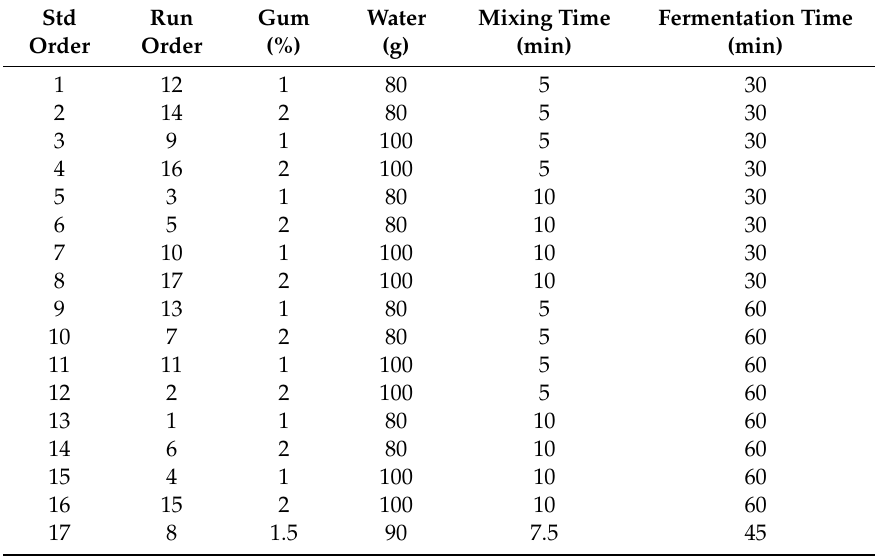
Fermentation Time (min)